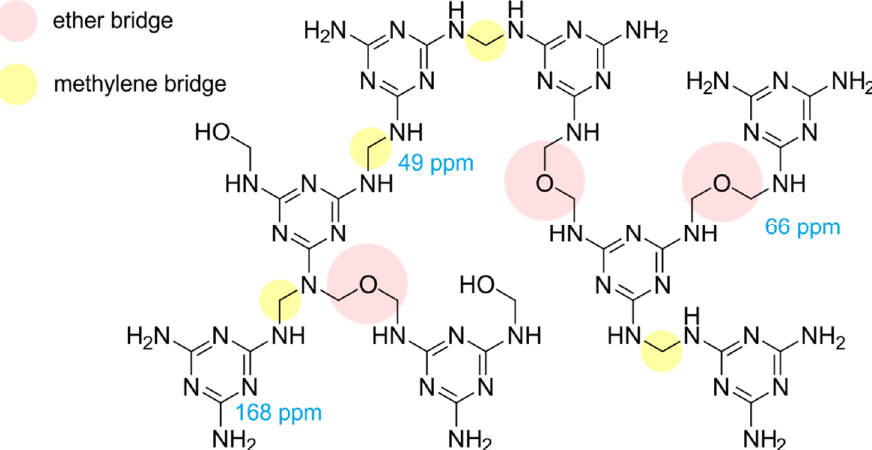
Figure 2. Possible crosslinks in a melamine resin, ether or methylene bridges, with selected 13 C-NMR chemical shifts taken from the literature [5,6,34].